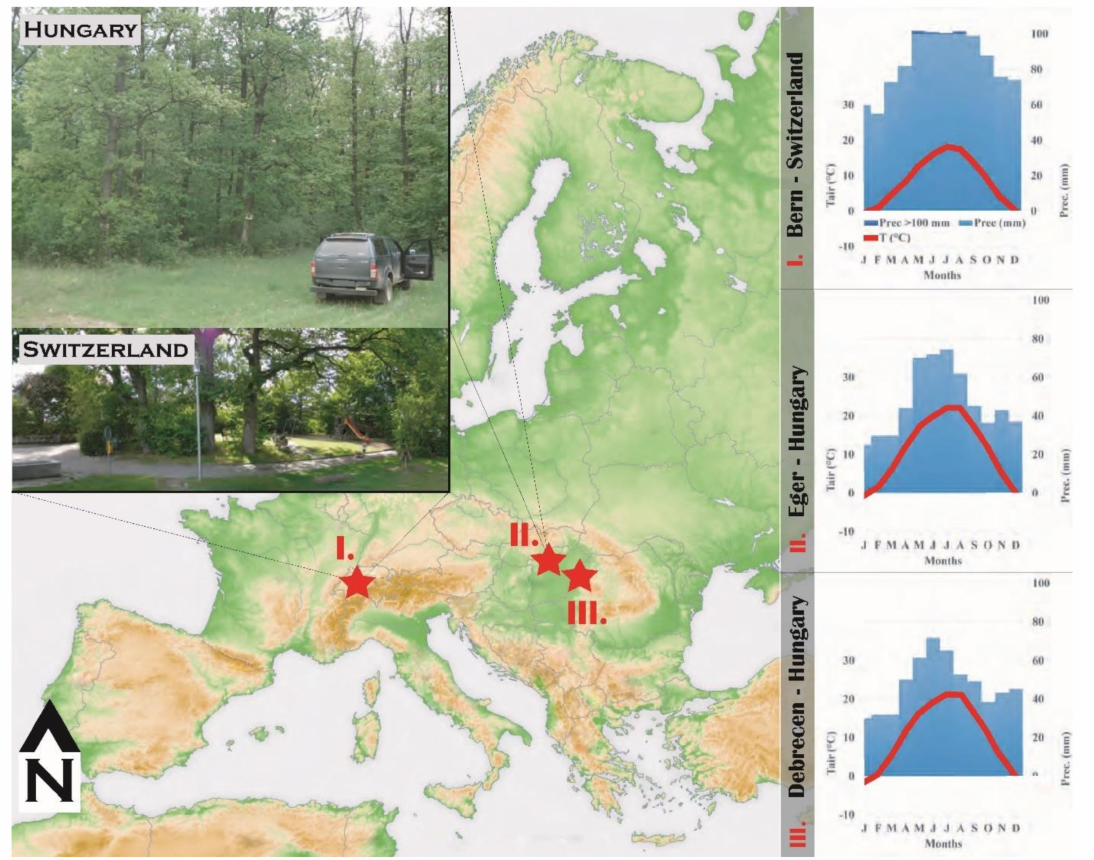
Figure 3. Sample sites in Hungary and Switzerland (red stars) with the corresponding climate diagrams